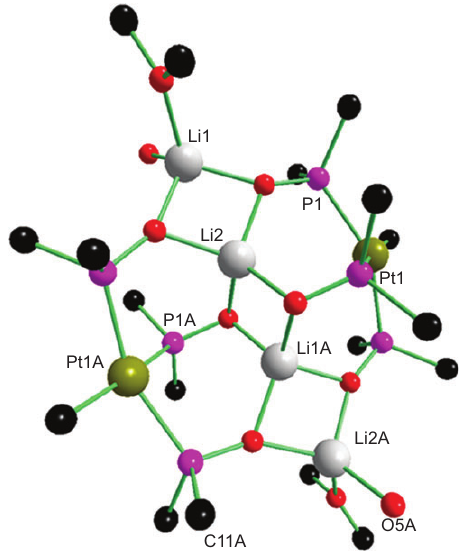
Figure 5 Molecular structure of [ { (Bu t C ≡ C)Pt( μ (thf) } ] (Falvello et al., 1999). Phenyl groups are omitted for 2